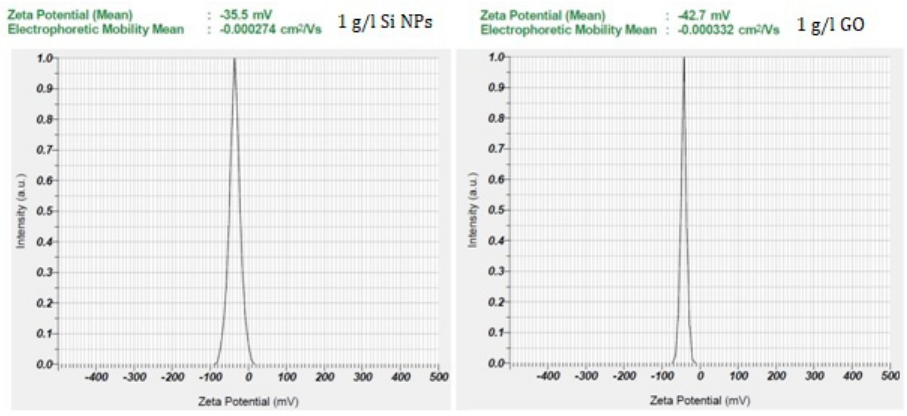
Figure 4. Zeta potential measurements.